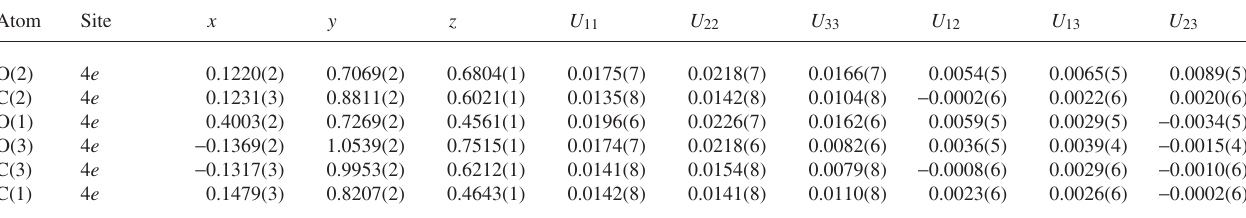
Table 3. Atomic coordinates and displacement parameters (in Å 2 )